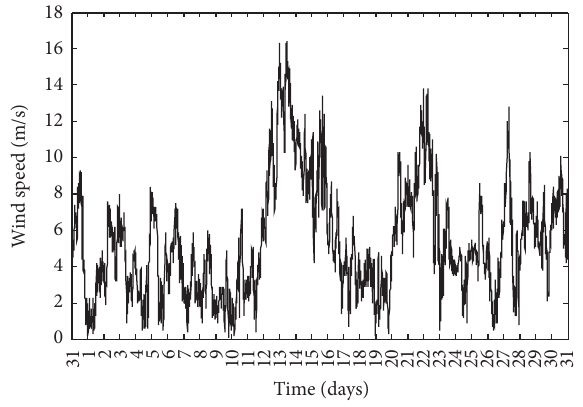
Figure 1: A typical monthly wind speed raw data.